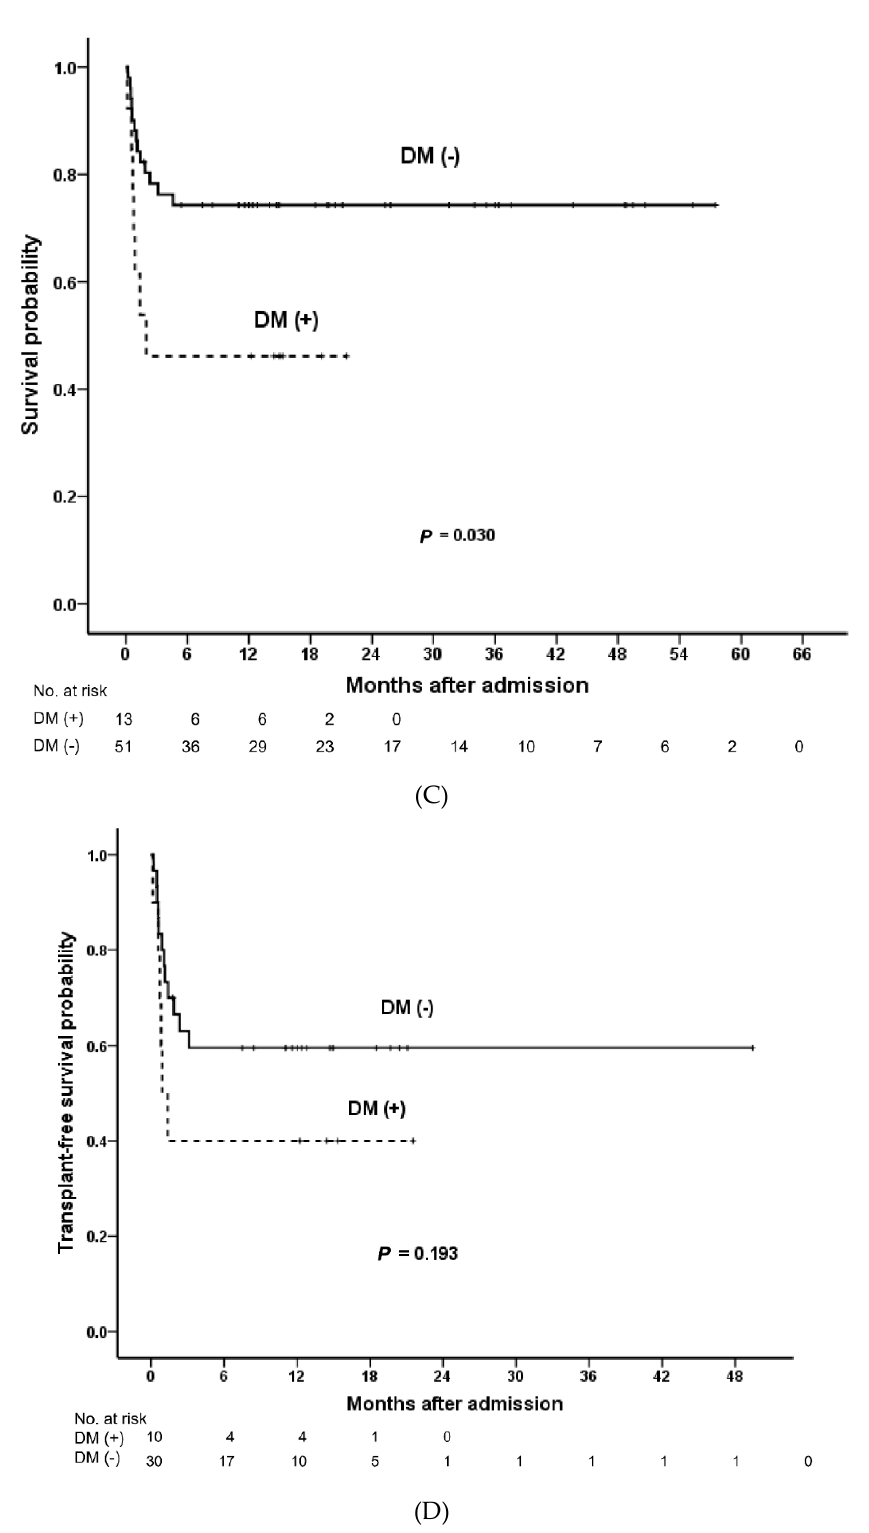
Figure 2. Overall survival in patients with acute-on-chronic liver failure. ( A ) Patients who received liver transplant vs. those who did not. ( B ) MELD score ≥ 30 vs. <30 in subgroup patients without transplant. Survival stratified based on the presence of DM in all patients ( C ) and the nontransplant group ( D ) DM, diabetes mellitus; MELD, Model for End-stage Liver Disease. Crude patient survival for patients with DM was lower than for those without DM ( p = 0.030; Figure 2C), and the same trend was observed in nontransplant patients with DM (Figure 2D). Compared with non-DM patients, patients with DM were associated with more hyperlipidemia (4/13